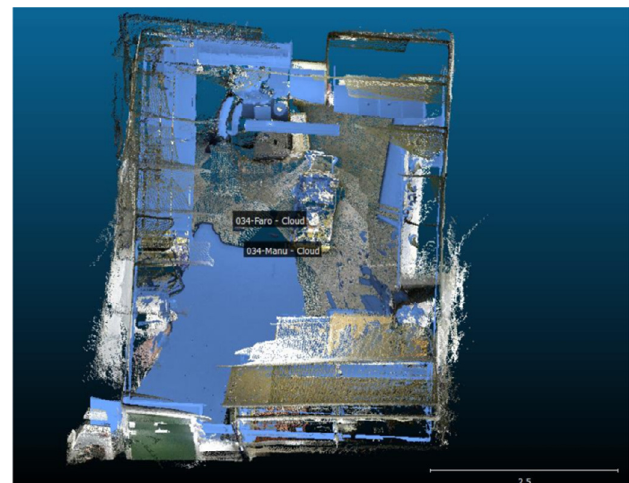
Fig. 16. Faro (blue)/MANUELA ® (RGB) point cloud super- position and registration.